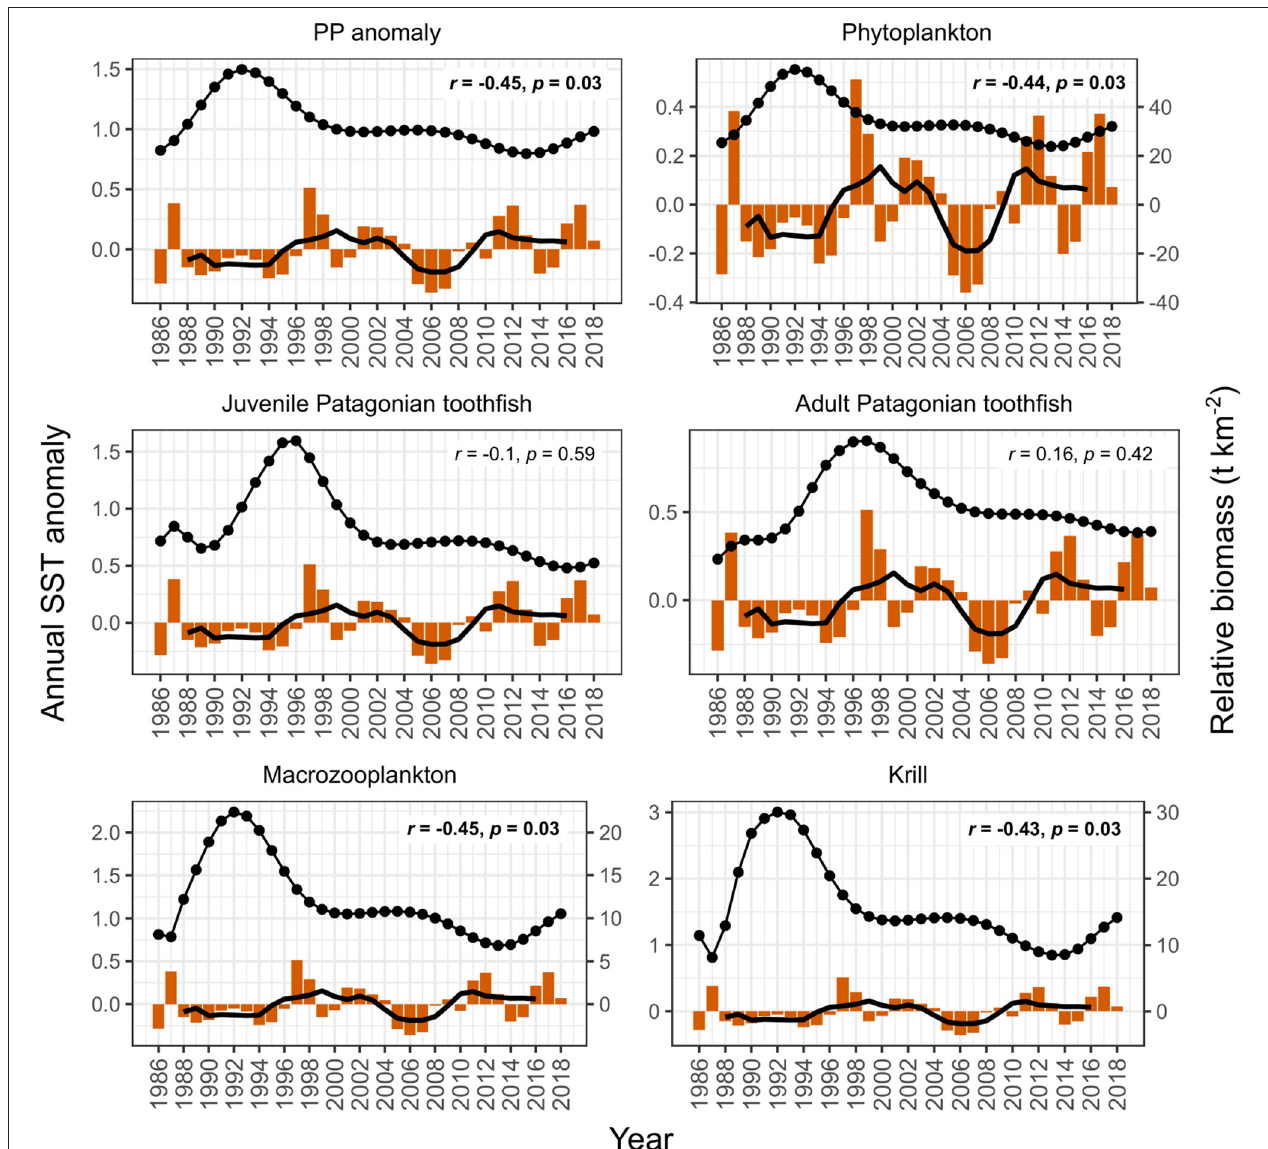
FIGURE 6 | Comparison of model output with annual sea surface temperature (SST) anomalies (orange bars). Black points are the estimated annual biomass values for each year of the model period and black line indicates moving average used to perform correlations (relative biomass in t km − 2 , right axis for phytoplankton, macrozooplankton, and krill). Strength of correlations are shown by the r and p values in each plot, with significant correlations in